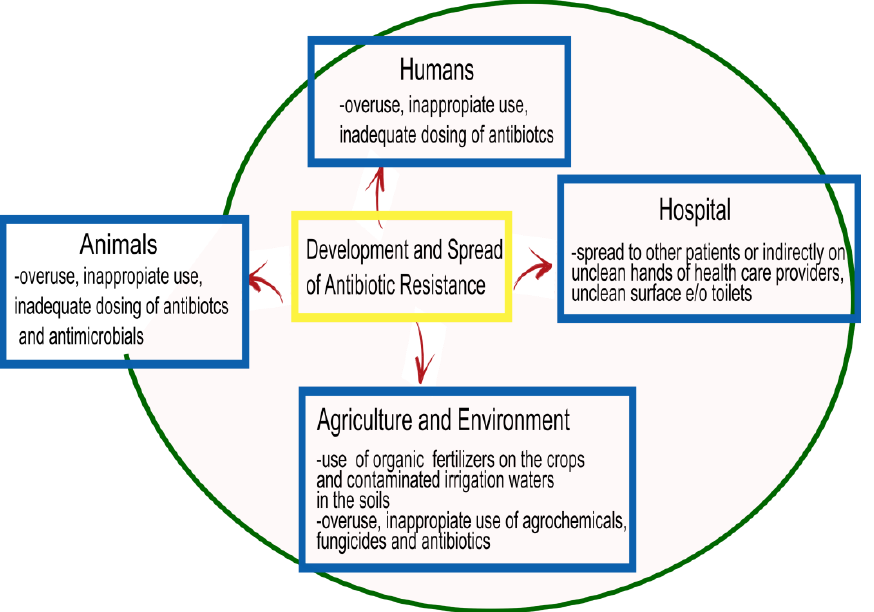
Figure 1. Factors involved in the diffusion of antibiotic resistance: human medicine in the community and in the hospital, animal production, and agriculture and environment.